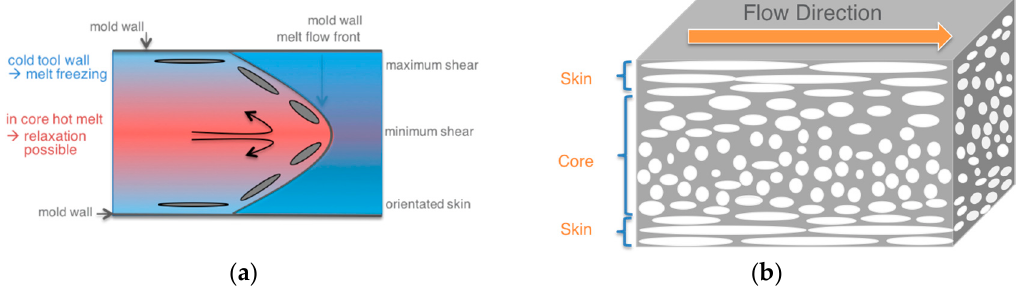
Figure 1. ( a ) Fountain flow experienced by polymers during injection molding of two-dimensional parts with a film gate (adapted from [17]) and ( b ) illustration of resulting profile of phase morphologies in the case of injection-molded parts made of blends of immiscible polymers.